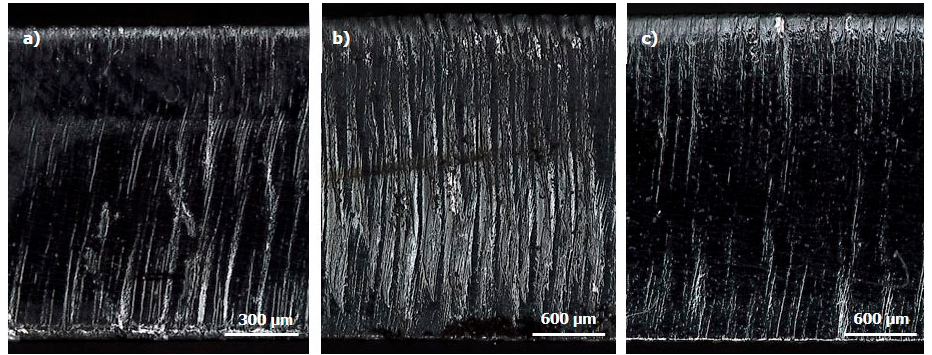
Figure 22. St37-2 kerf lateral surface: ( a ) 5 mm, Cs = 100% P = 100%; ( b ) 5 mm, Cs = 50% P = 100%; ( c ) 2.5 mm, Cs = 50% P = 100%.